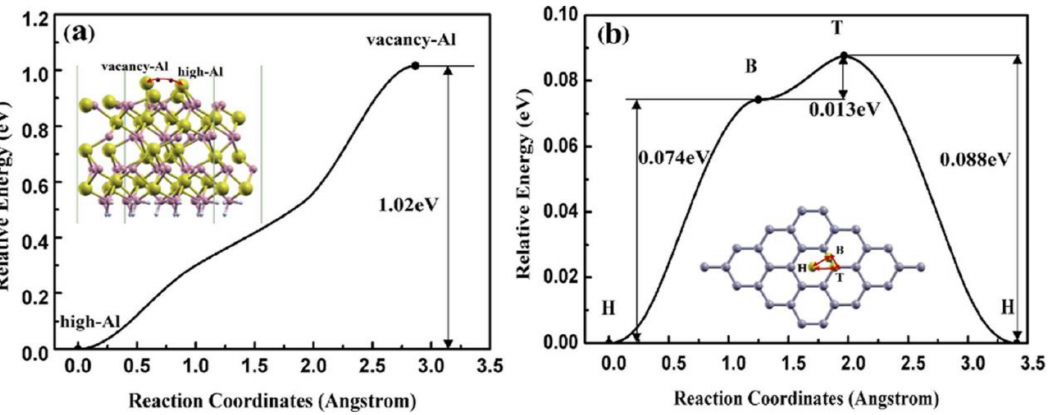
Figure 20. ( a ) The migration barrier of Al adatom on bare (0001) sapphire surface from the high-Al po- sition to vacancy-Al position. ( b ) The migration barrier of Al adatom on graphene-buffered sapphire between three different positions. Reprinted from [94], with the permission of AIP